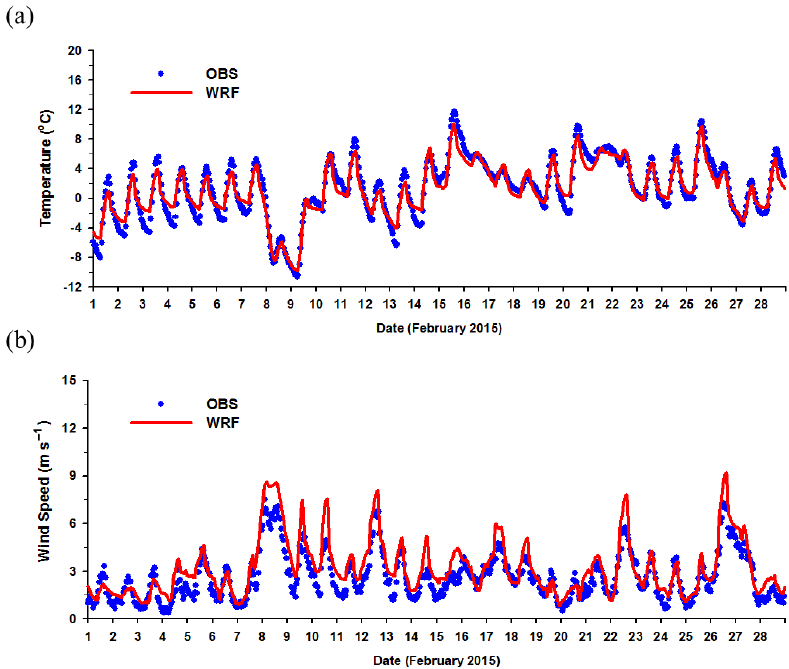
Figure 4. Time series of observed (OBS: blue dots) and WRF-simulated (WRF: red line) (a) temperature and (b) wind speed in Febru- ary 2015. The values are averaged values for 20 AQMS sites. Table 2. Statistical parameters of PM 10 concentrations at 20 AQMS sites in Korea for the simulations without the dust module (CMAQ), with the in-line dust module (CMAQ_Dust). Entire period Without dust events RMSE IOA MBE RMSE IOA